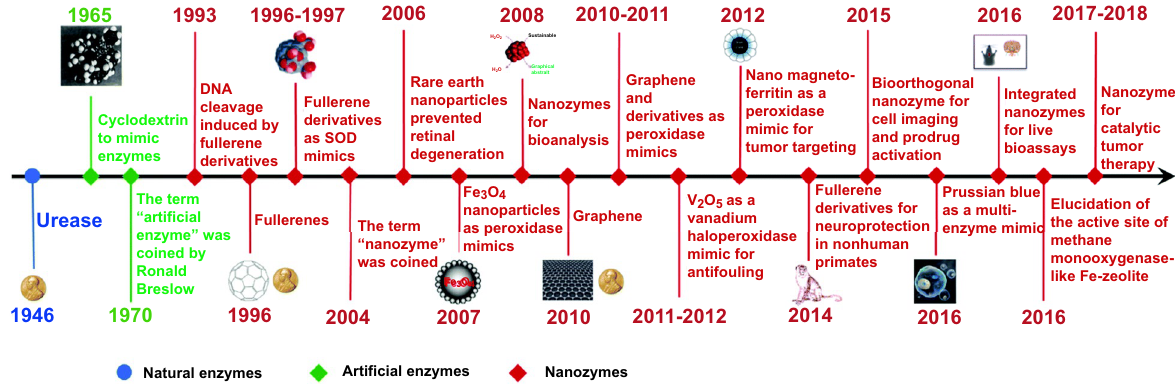
Fig. 1 A brief timeline for the evolution of artificial enzymes and natural enzymes. Reproduced from Ref. [22] with